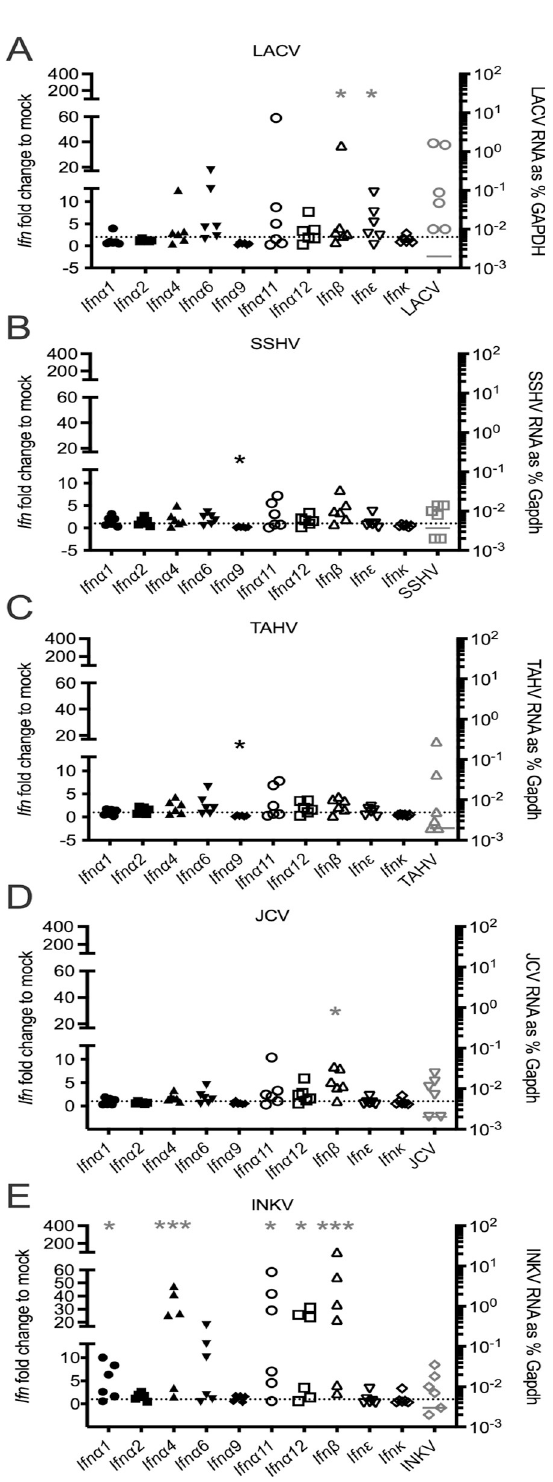
Fig 3. IFN response to CSG viruses in 1 dpi lymph nodes. IFN mRNA expression was evaluated via RT-qPCR for a panel of 10 Type I IFNs in lymph nodes taken at 1 dpi from mice inoculated with A) LACV; B) SSHV; C) TAHV; D) JCV; E) INKV. Expression is plotted for each samples as the fold change in %gapdh from the mock average. N = 6 for all viruses, n = 7 for mock. Each individual point represents an individual mouse. Dotted lines indicate fold change = 1. Fold change to mock is plotted on the left axis, viral RNA plotted on the right axis. One-way ANOVA analyses were